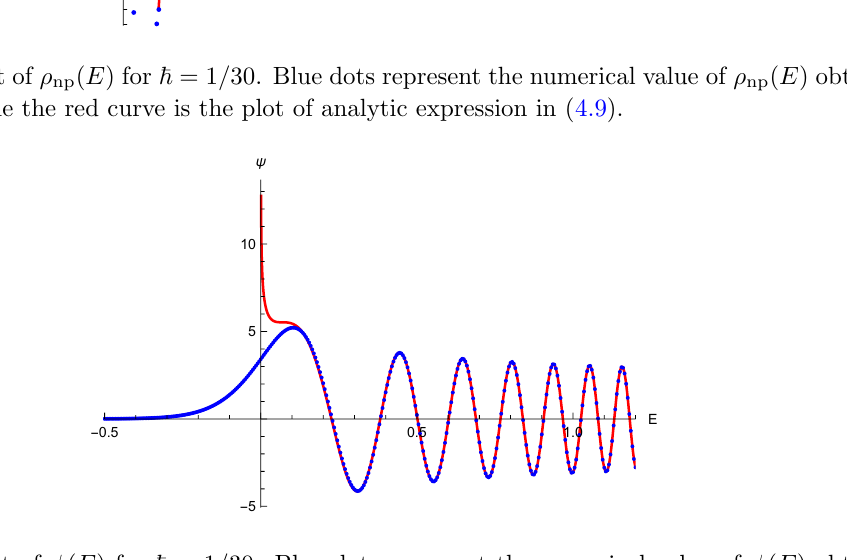
Figure 3 . Plot of ( E ) for ~ = 1 = 30. Blue dots represent the numerical value of ( E ) obtained from (4.10) while the red curve is the plot of analytic expression in